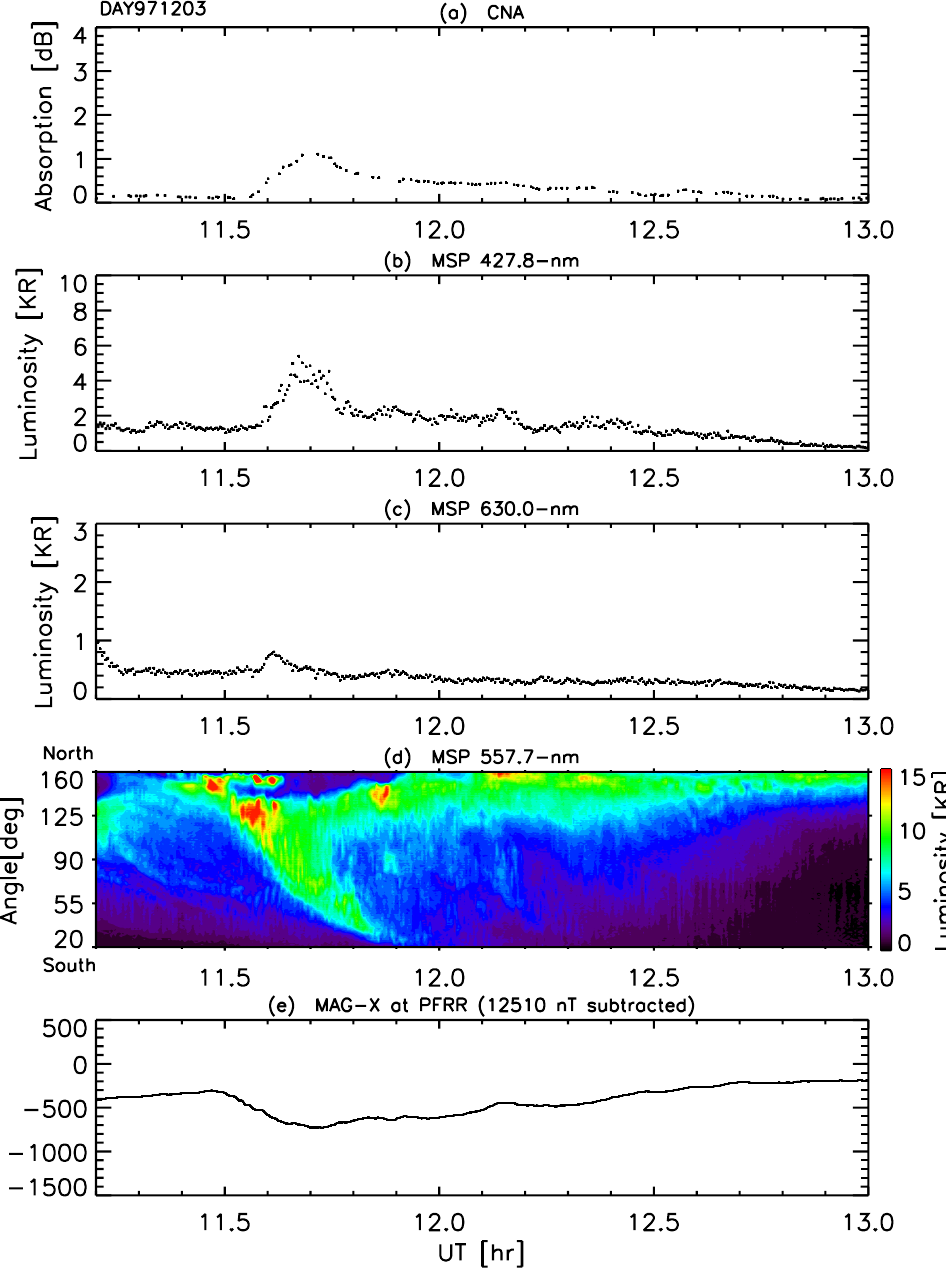
Fig. 1. Auroral activity observed in Poker Flat, Alaska, at 11:12 to 13:00UT on 3 December 1997. (a) CNA in the direction of the geomagnetic zenith, measured by the imaging riometer. (b) 427.8-nm brightness in the direction of the geomagnetic zenith, measured by the MSP (Meridian Scanning Photometer). (c) 630.0-nm brightness in the direction of the geomagnetic zenith, measured by the MSP.